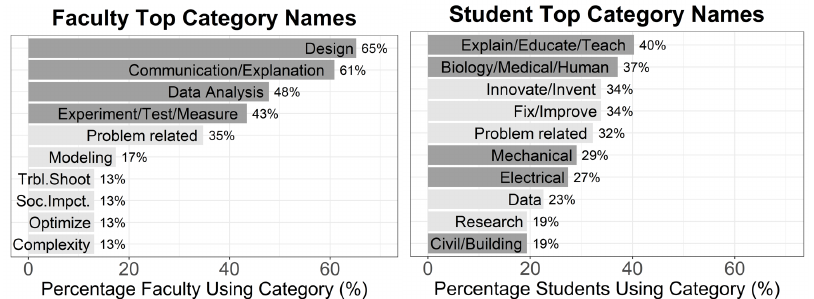
Fig. 5. Top 10 category names used by faculty (n=23, left) and by students (n=62, right) based on qualitative analyses of sort data. Values shown indicate the percentage of each par- ticipant group that used each code, and darker grey bars indicate a match with hypothe- sized group names. The top four names used by faculty match our activity features, while the discipline features (and communicate) can be found in the top student catego- ry